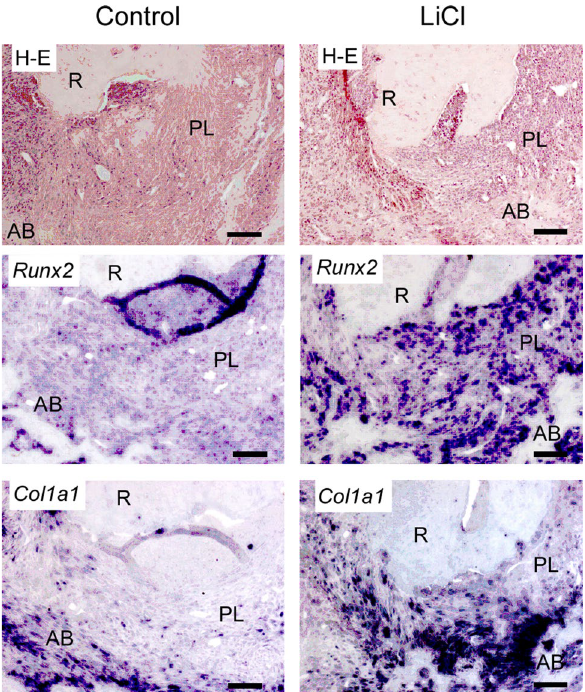
Figure 6. Activation of the Wnt/β-catenin signaling pathway resulted in the spreading of the expression areas of osteoblast differentiation markers. Periapical lesion tissues of the control group and the LiCl application group were subjected to H–E staining and in situ hybridization for Runx2 and Col1a1 . R root, PL periapical lesion, AB alveolar bone. Scale bars = 100 μm.